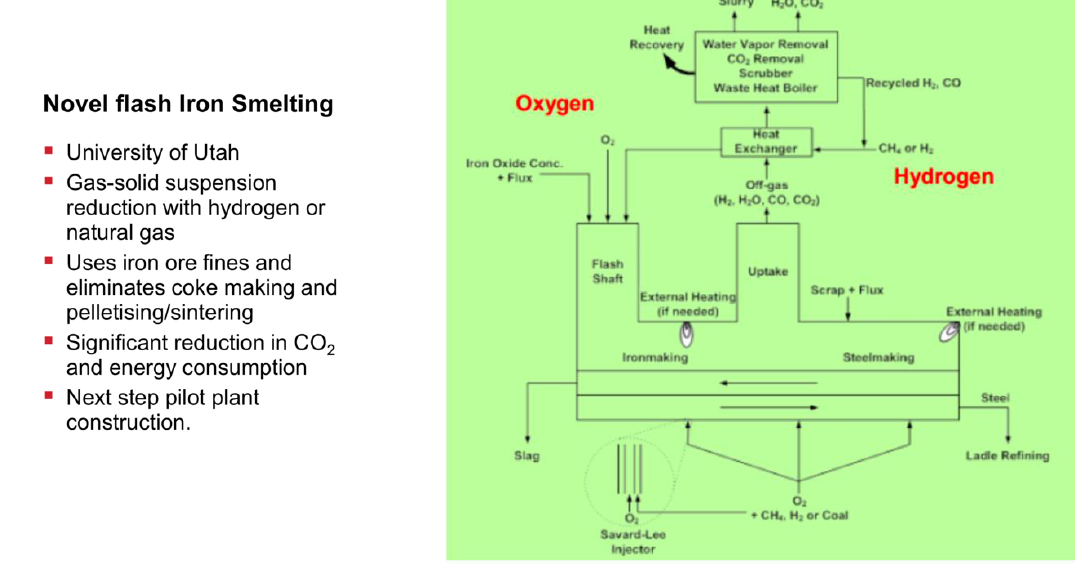
Figure 24. The MOE process of D. Sadoway.